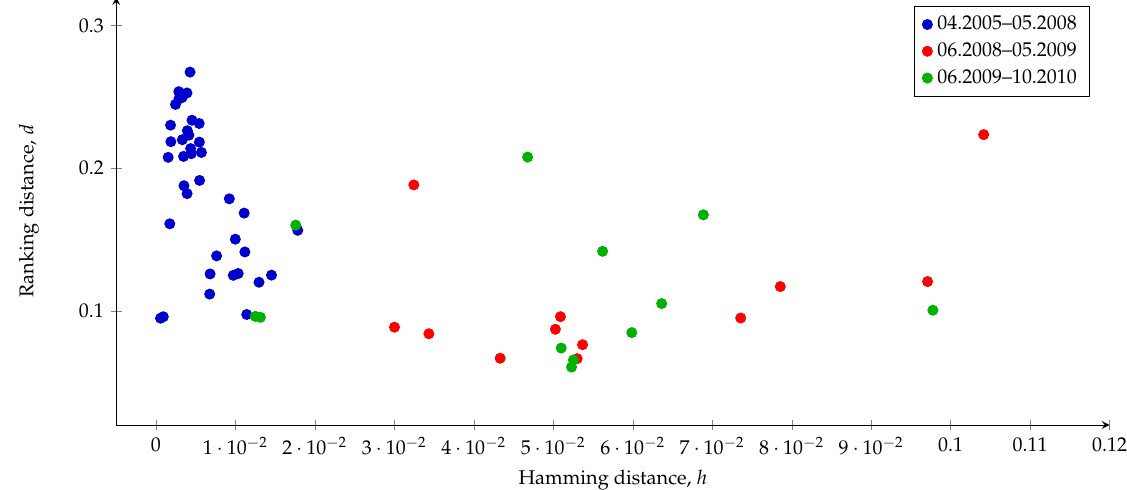
Figure 3. The evolution of ranking and the Hamming distances between each pair of market graphs constructed for every pair of consecutive six-month periods, i.e., 1–2, 2–3, ...,